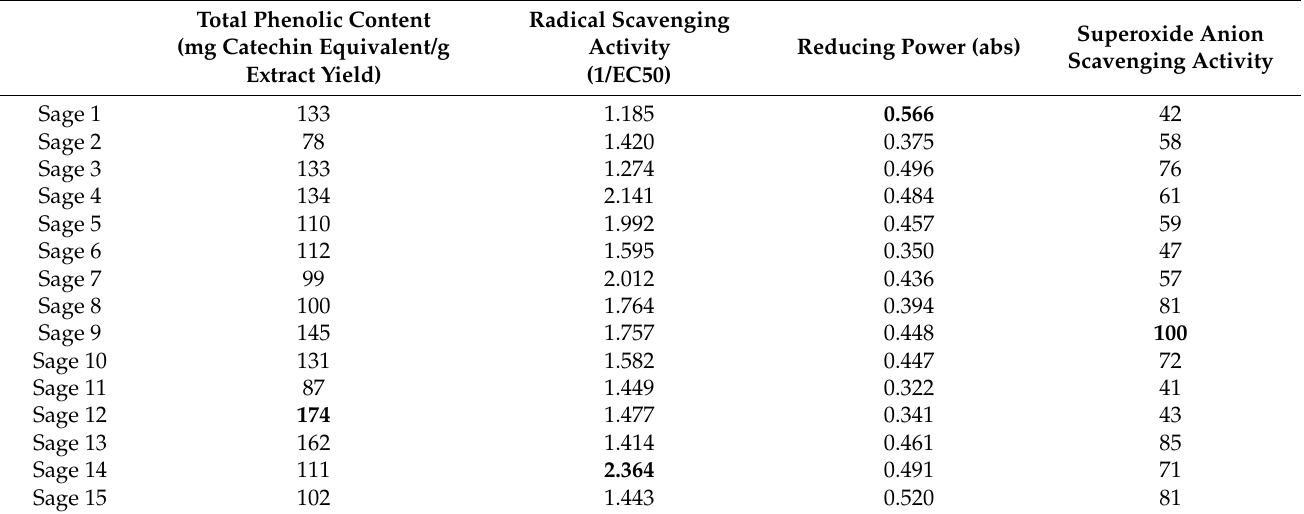
Table 2. Total phenolic content and antioxidant capacity of 15 sage samples were determined as relative radical scavenging activity, reducing power, and superoxide anion scavenging activity. The sample with the highest total phenolic content and highest antioxidant capacity, respectively, according to each method, is marked in bold.